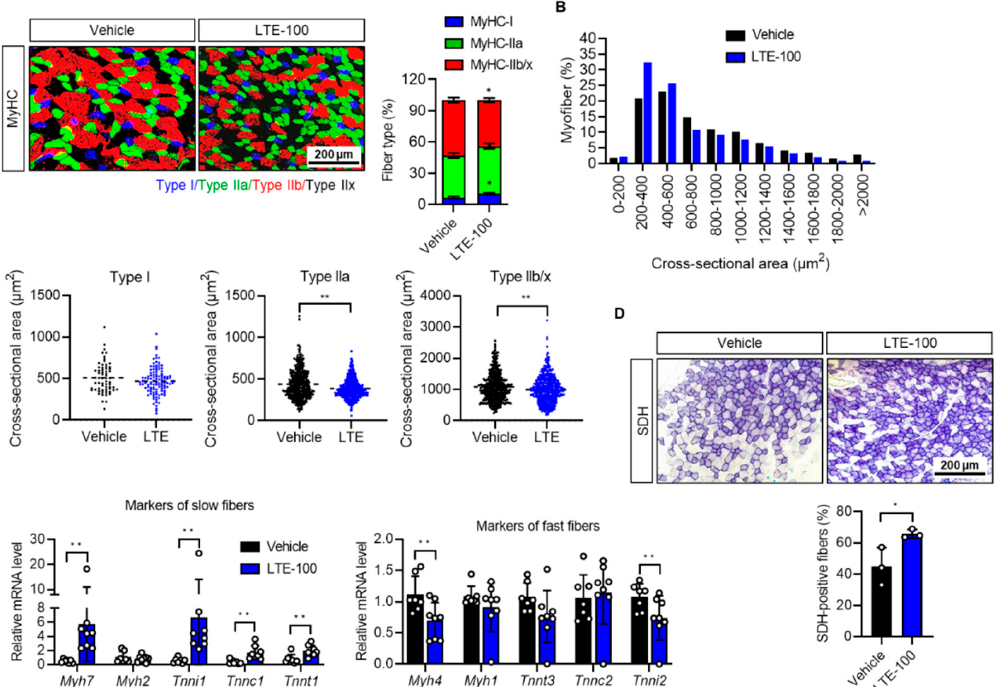
Figure 3. Effects of LTE supplementation on the proportion of muscle fiber-types. ( A ) Representative microscopic images of GAS muscles immunostained with anti-MyHC antibodies (types I, IIa, IIb, and IIx). The number of the different types of muscle fibers was counted manually ( n = 5). Results are graphed as a percentage of the total number of fibers per muscle. ( B ) The quantification of the cross-sectional area of each type of myofibers in GAS muscles of mice is described in ( A ). ( C ) The cross-sectional area of each type of muscle fiber was determined based on the expression of MyHC-positive myofibers. ( D ) Succinate dehydrogenase (SDH) activity staining was performed on sections of GAS muscle ( n = 3). ( E ) mRNA levels of known markers of type I and type II fibers were analyzed by qPCR. mRNA levels were standardized against Gapdh and plotted relative to the expression in vehicle-treated mice ( n = 7–8). Values are mean ± S.E.M., * p < 0.05 and ** p < 0.01. LTE-100, LTE 100 mg/kg p.o.